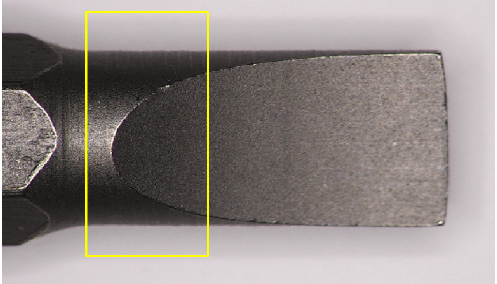
Figure 3. Example object not suitable for interest point